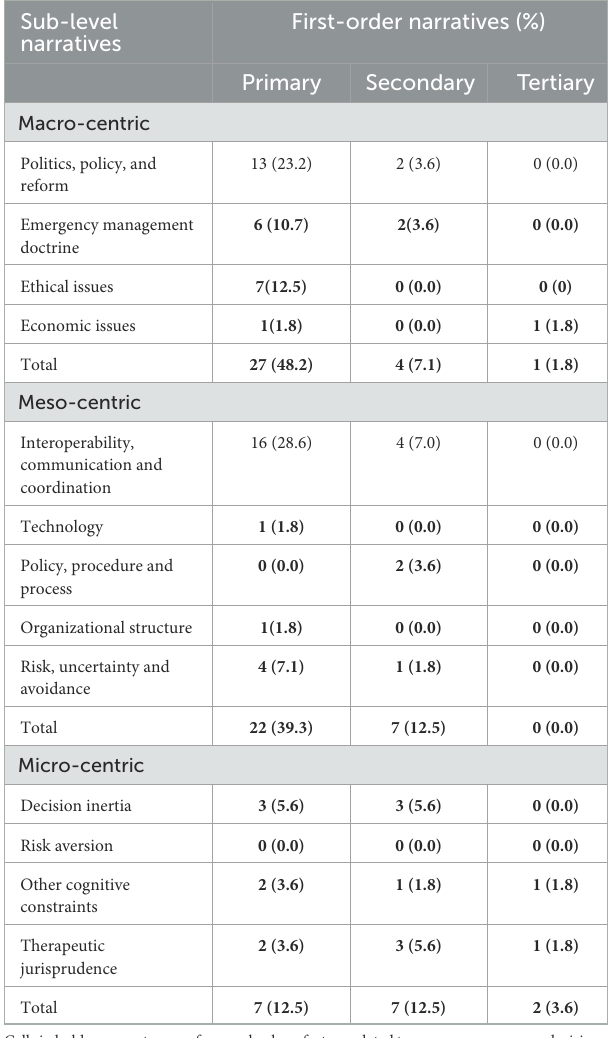
TABLE 3 Narrative bibliometric coding, showing the identification of first-order narratives categorized against sub-level narratives. Sub-level